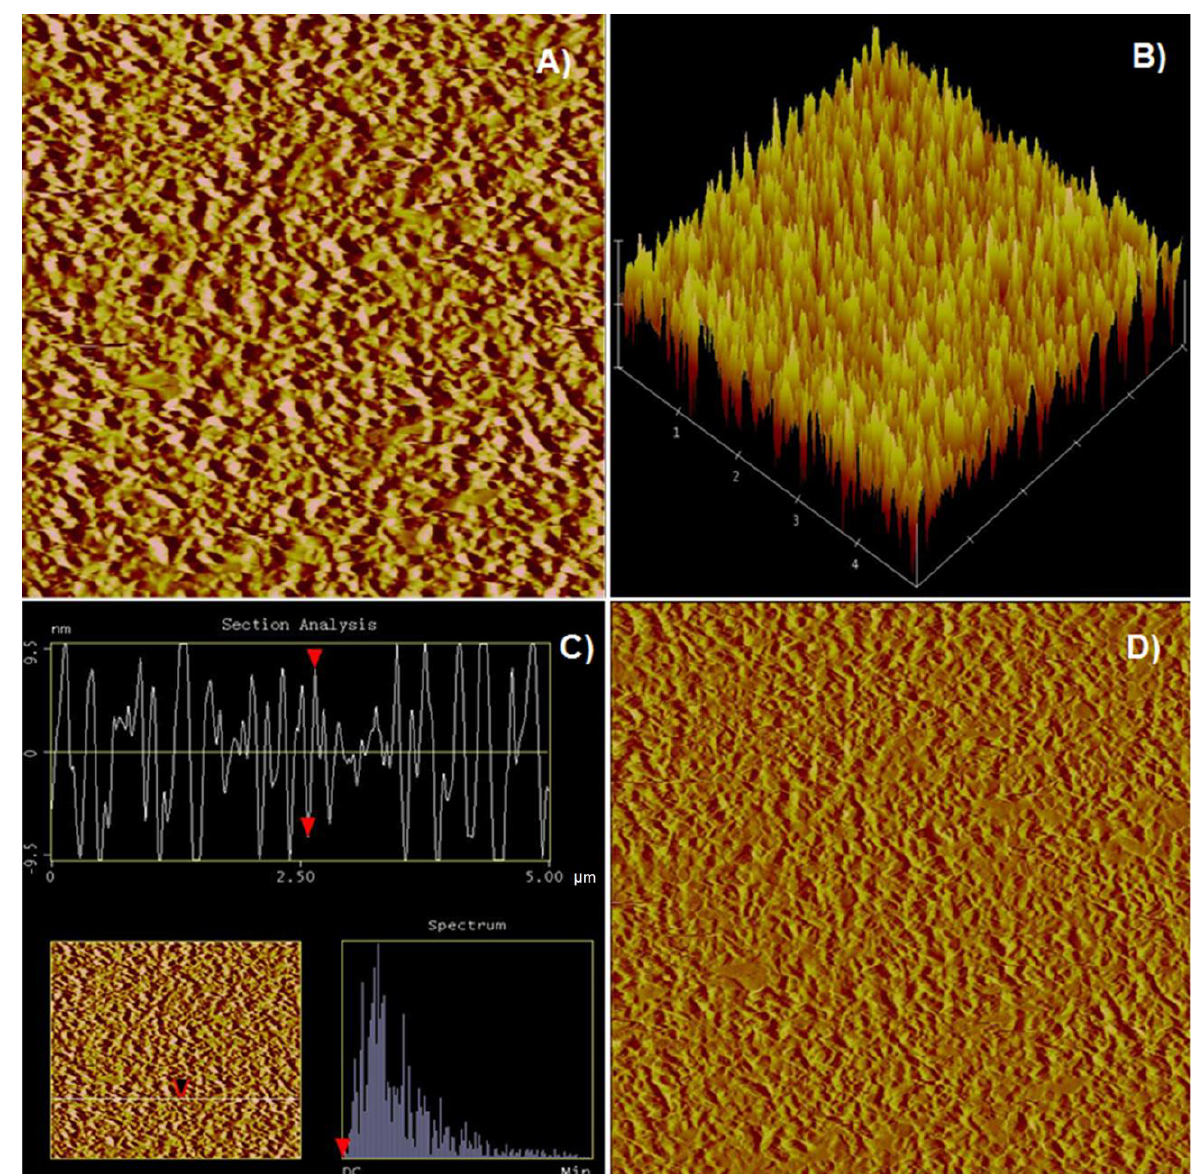
Figure 6. AFM images of a bornite surface soaked in the 5 × 10 − 4 M KEX solution at pH 6 for 10 min. ( A ) The 5 µm × 5 µm height image with a data scale of 20 nm, ( B ) the 3D image, ( C ) the section analysis (the red arrows indicate the top and the bottom of an average asperity) and ( D ) the deflection image with a data scale of 10 nm.